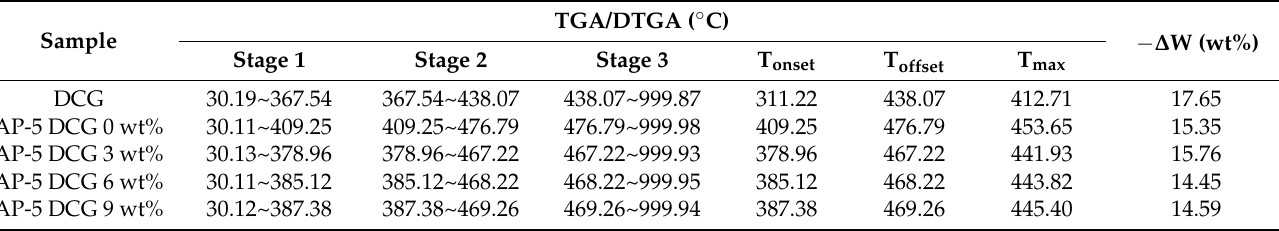
Figure 17. DTGA thermograms of DCG, base AP-5 asphalt, and its specimens containing various fractions of DCG (e.g., 3, 6, 9 wt%). Table 3. TGA and DTGA thermogram data of DCG, base AP-5 asphalt, and DCG-AP-5 mixtures comprising 3, 6, and 9 wt% DCG loading at a heating rate of 20 ◦ C min − 1